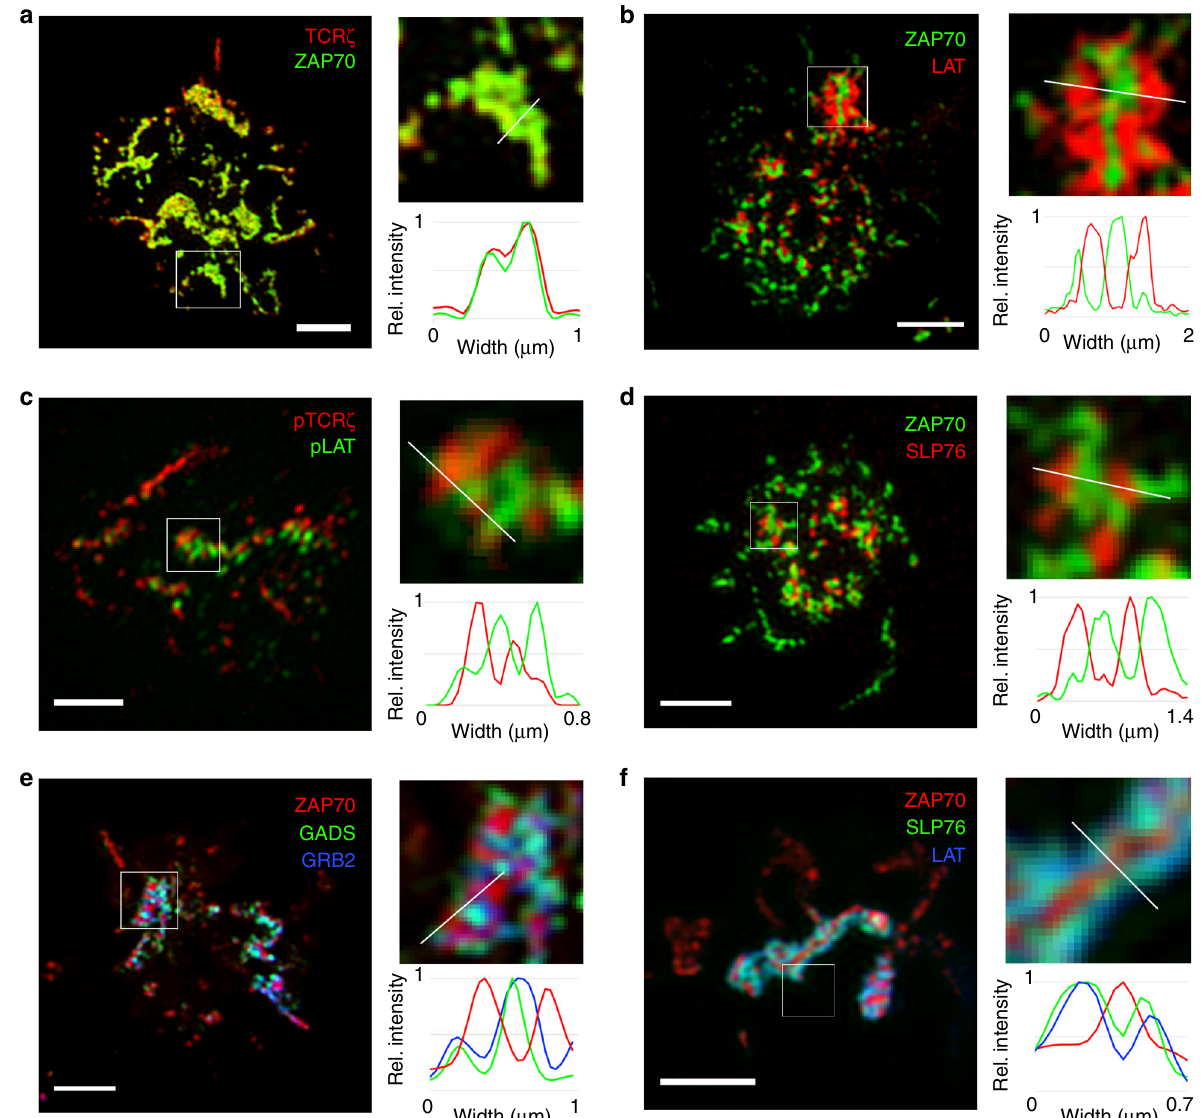
Fig. 1 TIRF-SIM imaging of microclusters show distinct receptor and signaling domains. TIRF-SIM images of microclusters formed in Jurkat T cells activated on coverslip-bound anti-CD3 antibody were visualized using a TCR ζ -Halo-JF646 (red) and ZAP70-Emerald (green), b ZAP70-Emerald (green) and LAT- Halo-JF646 (red), c anti-pTCR ζ Y142; red) and anti-pLAT (Y226; green), d ZAP70-Emerald (green) and SLP76-Halo-JF646 (red), e GADS-Emerald (green), ZAP70-Apple (red), and GRB2-Halo-JF646 (blue), and f LAT-Emerald (blue), ZAP70-Apple (red), and SLP76-Halo-JF646 (green). a – f Upper right image was magni fi ed from the region marked by a white box in the left image, and the bottom right graph shows relative (rel.) intensity measured across the width of the white line in the corresponding upper right image. a – f Scale bars in left images, 4 μ